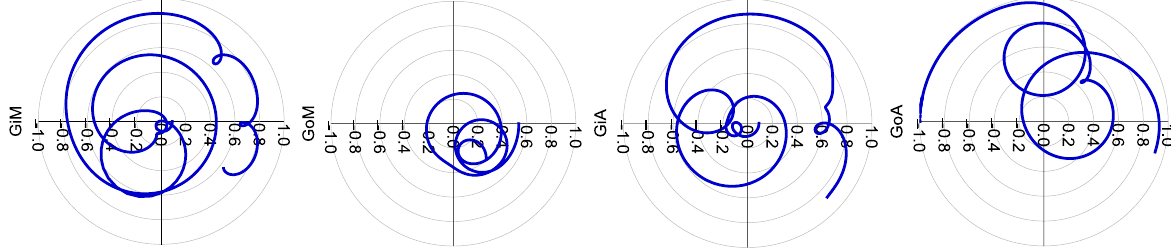
Figure 10. Nyquist plot of the open-loop function for the proposed Doherty power amplifier (DPA) from 100MHz to 6GHz.